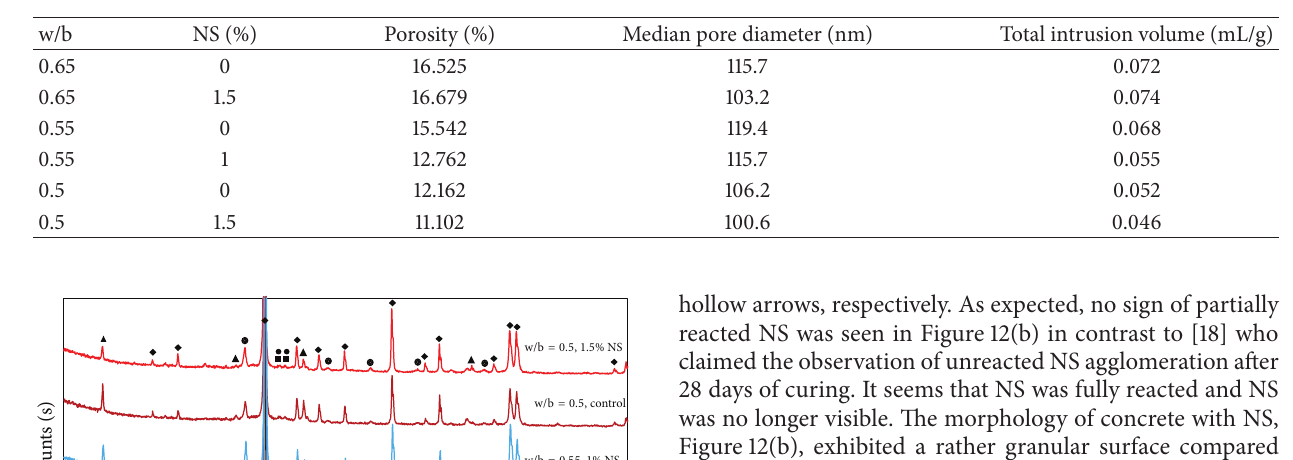
Table 4: Total porosity percentage, median pore diameter and intrusion volume of pores for selected concrete mixes.